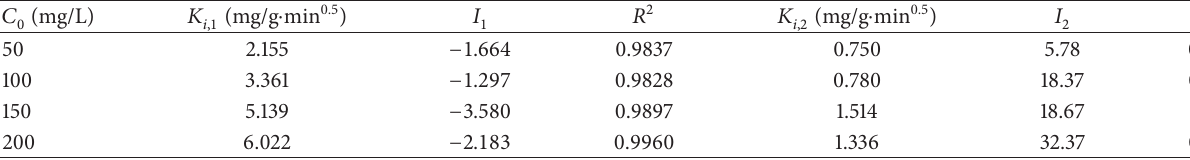
Table 6: Intraparticle diffusion constants for different initial MB concentration.